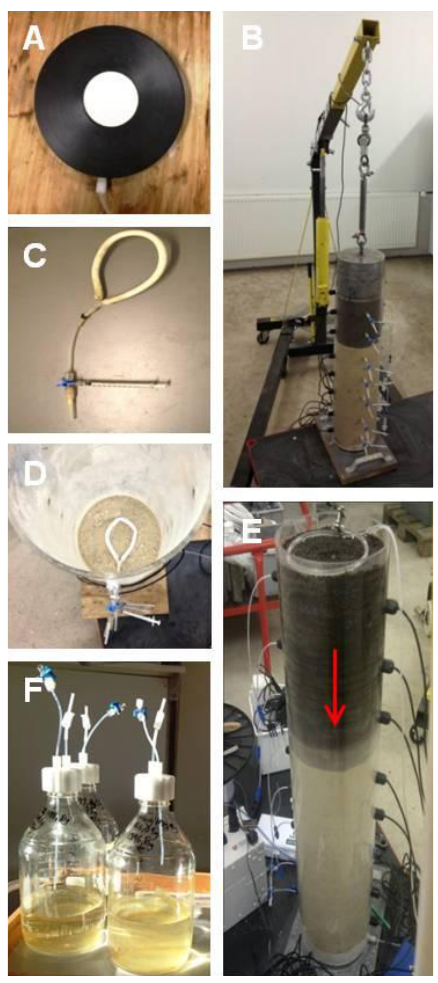
Fig. 2. Mesocosm construction for measurement of DIC fluxes in the vadose zone. (A) PEHD plate as bottom of the mesocosms with integrated filter disc. A 3mm-wide hole (not visible) connects a nar- row cavity under the filter disc with the mesocosm outlet, allowing for controlled suction pressure at the mesocosm bottom. (B) Each 30mm soil layer is compacted by a weight that is above the wet tare of the overlying soil column at the given depth. (C) Gas sam- pler. (D) Gas sampler built into a soil layer in the mesocosm. (E) Mesocosm with irrigation tubing during watering of a newly con- structed, dry mesocosm. Red arrow indicates infiltration front. (F) Vacuum flasks for effluent collection.